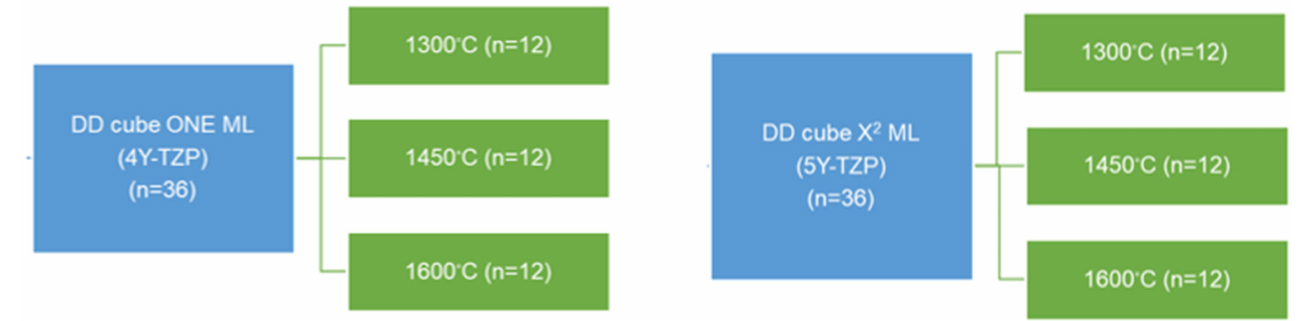
Figure 2. Study design and distribution of bar-shaped samples for flexural strength testing regardless of the